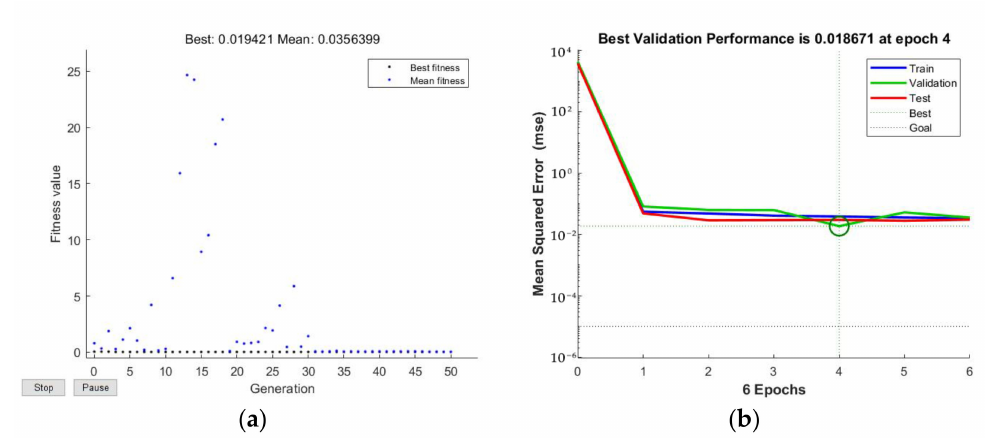
Figure 12. ( a ) GA iterative process, ( b ) GA-BPNN training completion chart. The four test sample design elements were coded as GA -BPNN input data for predic- tion, and the results showed that the GA-BPNN prediction ( was closer to the user evaluation values ( than the BPNN prediction ( )), as shown in Figure 13.